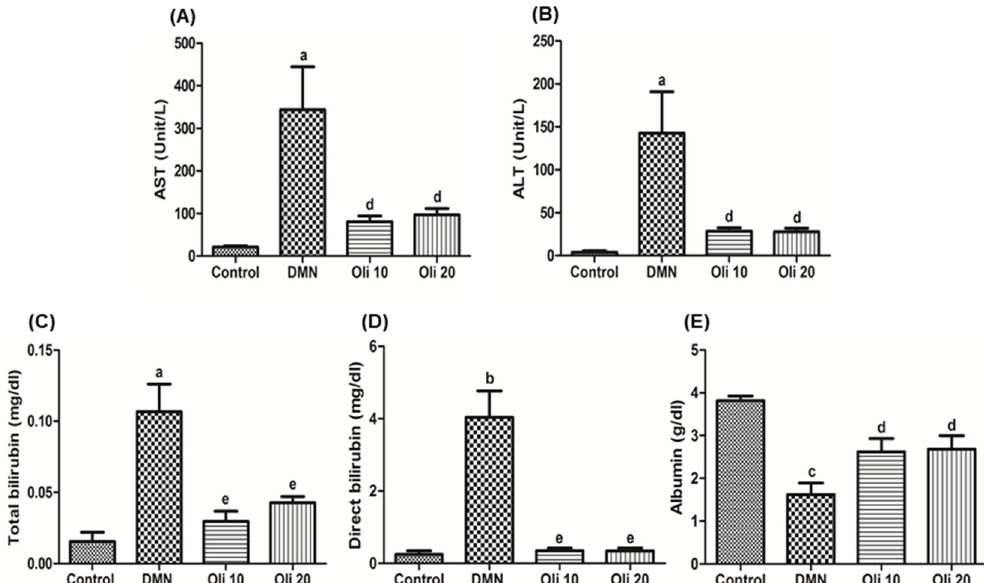
Figure 2. Changes in serum parameters in Rats Intoxicated by DMN. ( A ) Aspartate transaminase (AST); ( B ) Alanine transaminase (ALT); ( C ) Total bilirubin; ( D ) Direct bilirubin; ( E ) Albumin. Groups are as described in “Materials and Methods”. Values are mean ± SE of n = 6 rats/group. a p < 0.05, b p < 0.01, and c p < 0.001 vs. the control group, and d p < 0.05 and e p < 0.01 vs. the DMN group.